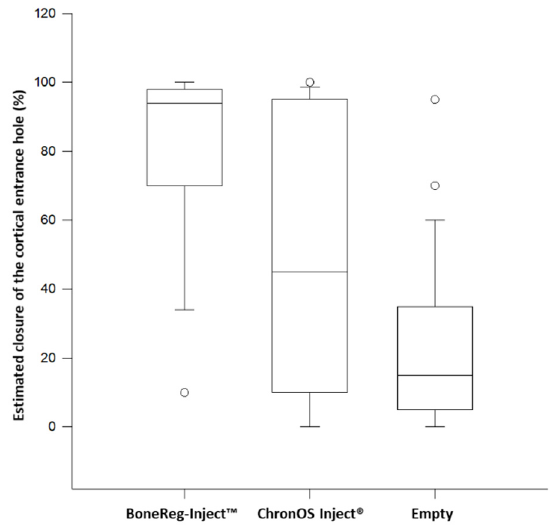
Figure 4. Scoring of percentage closure of cortical entrance hole in the two test groups and the empty holes in both groups 3 months postoperatively shown as box plot based on results from ANOVA on ranks, and only showing a significant difference between BoneReg-Inject™ and empty hole (Empty), Dunn’s Method, p < 0.05. Boxes show a 50% confidence limit and bars show a 90% confidence limit. The median is indicated by the horizontal line within the boxes. (BoneReg-Inject™ n = 15; chronOS Inject ® n = 14; Control n = 29).